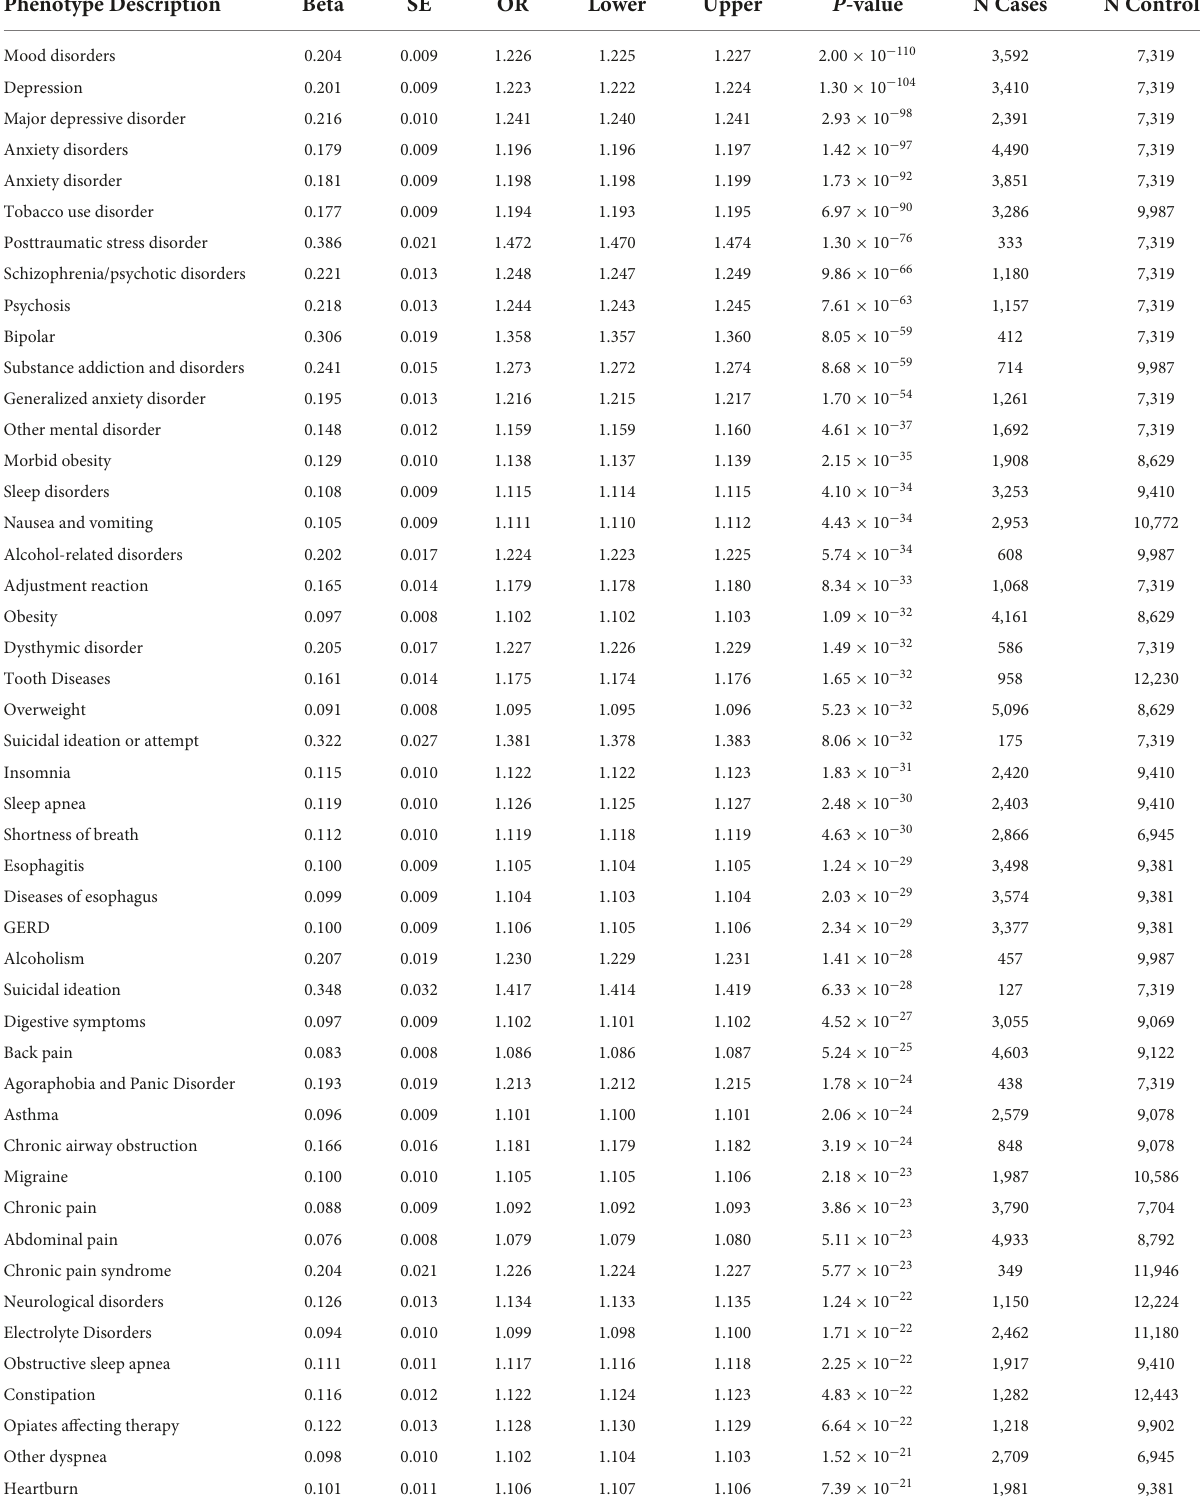
TABLE 4 Most significant associations of the dose-response phenome-wide association